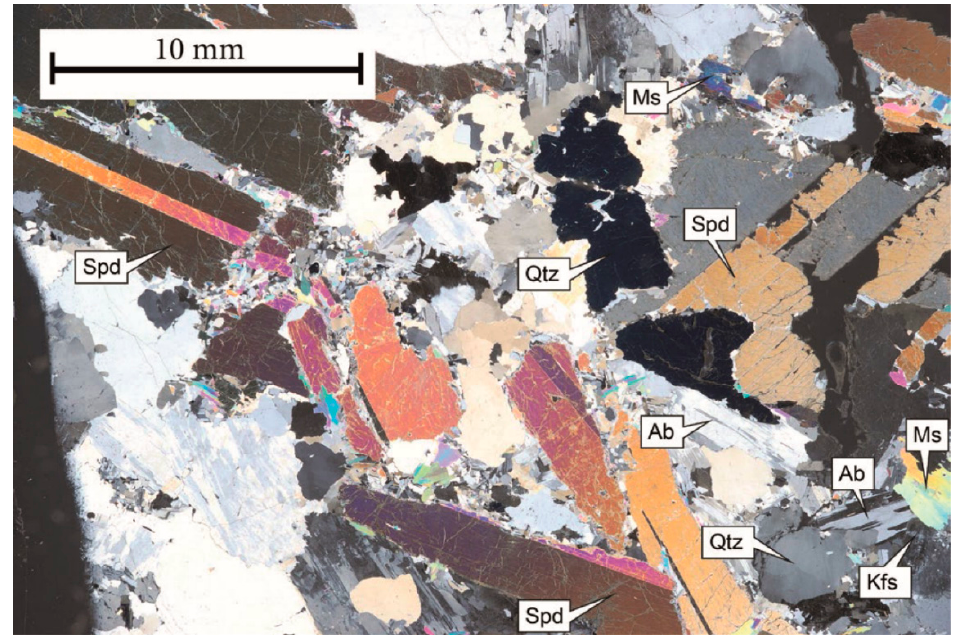
Figure 10. Thin section of spodumene pegmatite from drill core in the Leviäkangas exploration area, Kaustinen Li pegmatite province. Mineral abbreviations: Spd (Spodumene), Qtz (Quartz), Kfs (Potassium feldspar, Ab (Albite), Ms (Muscovite). From Ahtola et al. (2015) [56].